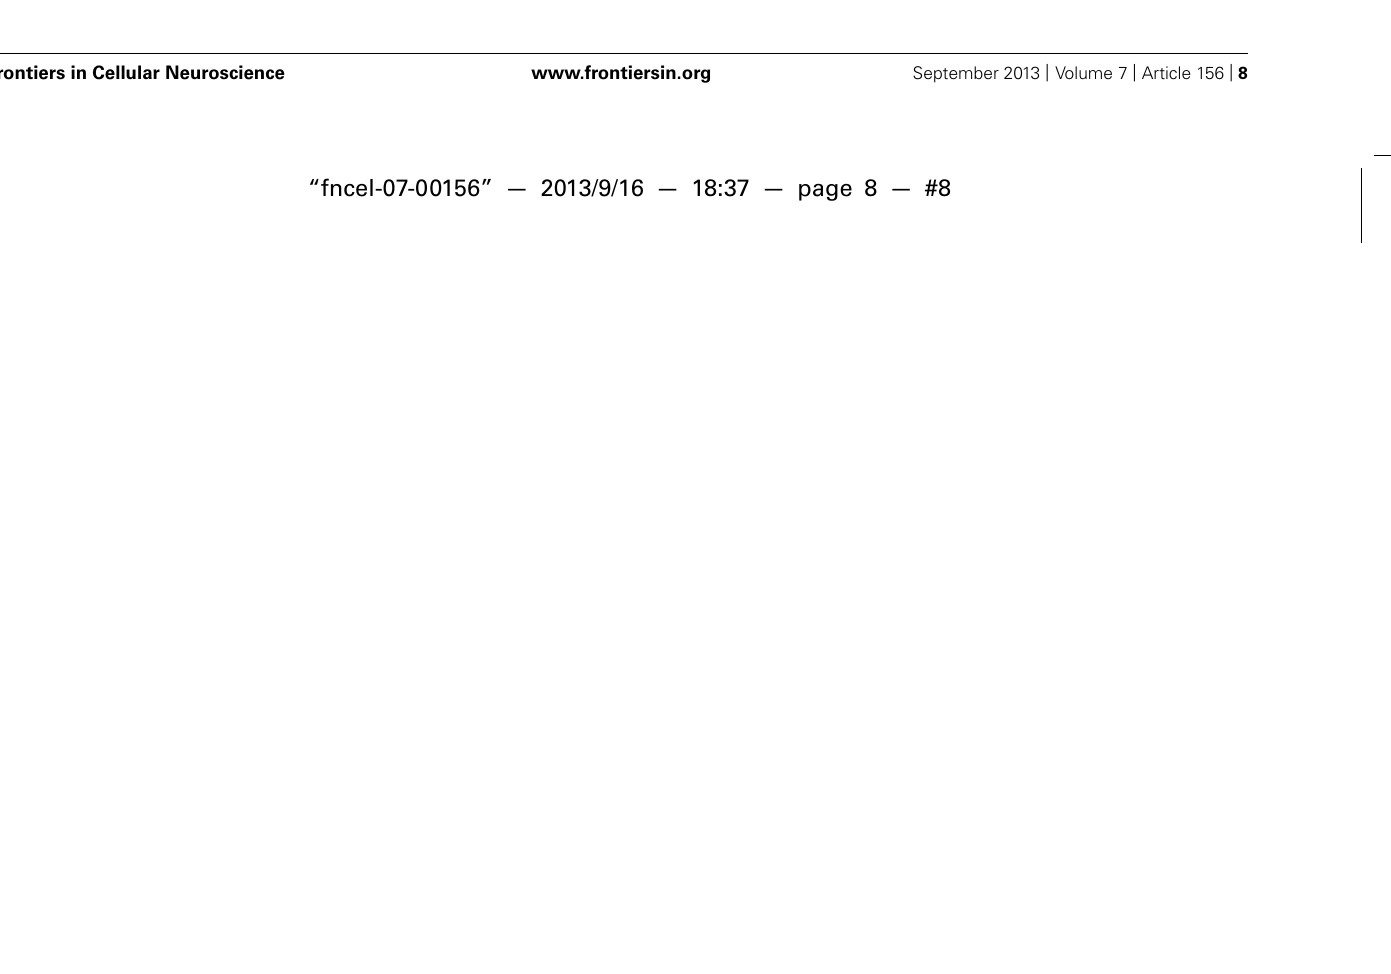
FIGURE 8 | Paradoxical exacerbation in stargazer cortex requires GABAergic synaptic transmission. (A,B) Spontaneous 0 Mg 2 + - induced network discharges in WT and stargazer cortex (upper traces) are accelerated by combined GABA A and GABA B receptor blockade (middle traces); however, in this disinhibited condition, application of